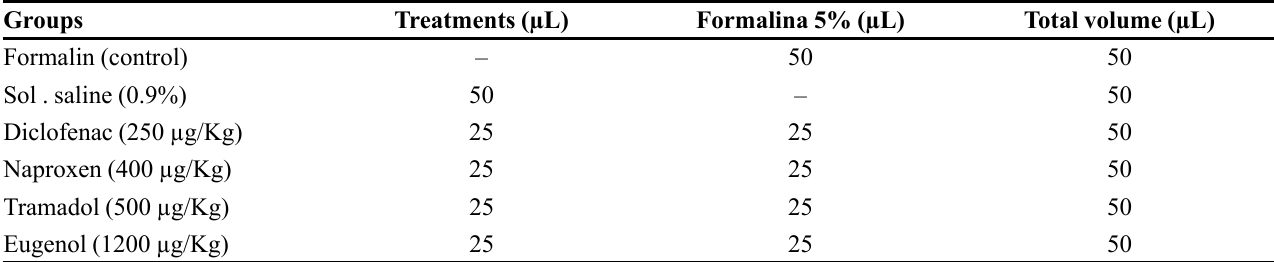
TABLE I - Distribution of experimental groups Groups